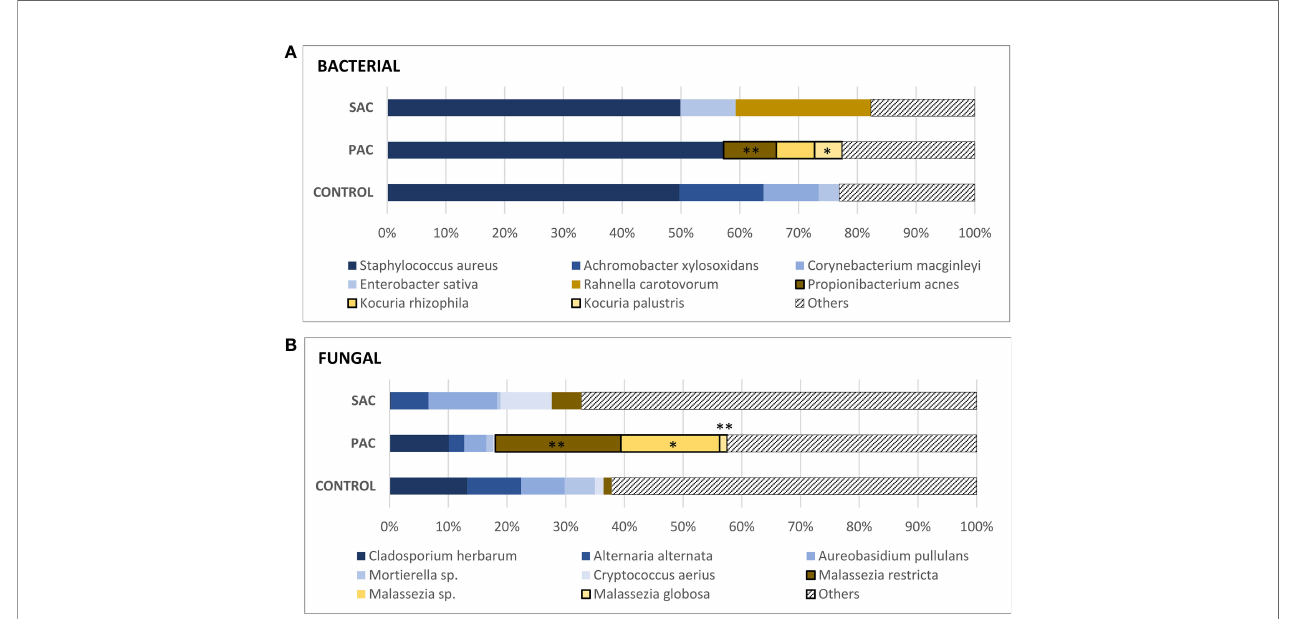
FIGURE 2 | Mean values of the most common species of bacteria (A) and fungi (B) . Propionibacterium acnes (PAC: 9.01 ± 9.93%), Kocuria rhizophila (PAC: 6.49 ± 19.46%) , K. palustris (PAC: 4.71 ± 9.26%). Malassezia restricta (SAC: 5.01 ± 12.19%, PAC: 21.71 ± 18.54%, C: 1.28 ± 2.03%), Malassezia species. (PAC: 17.07